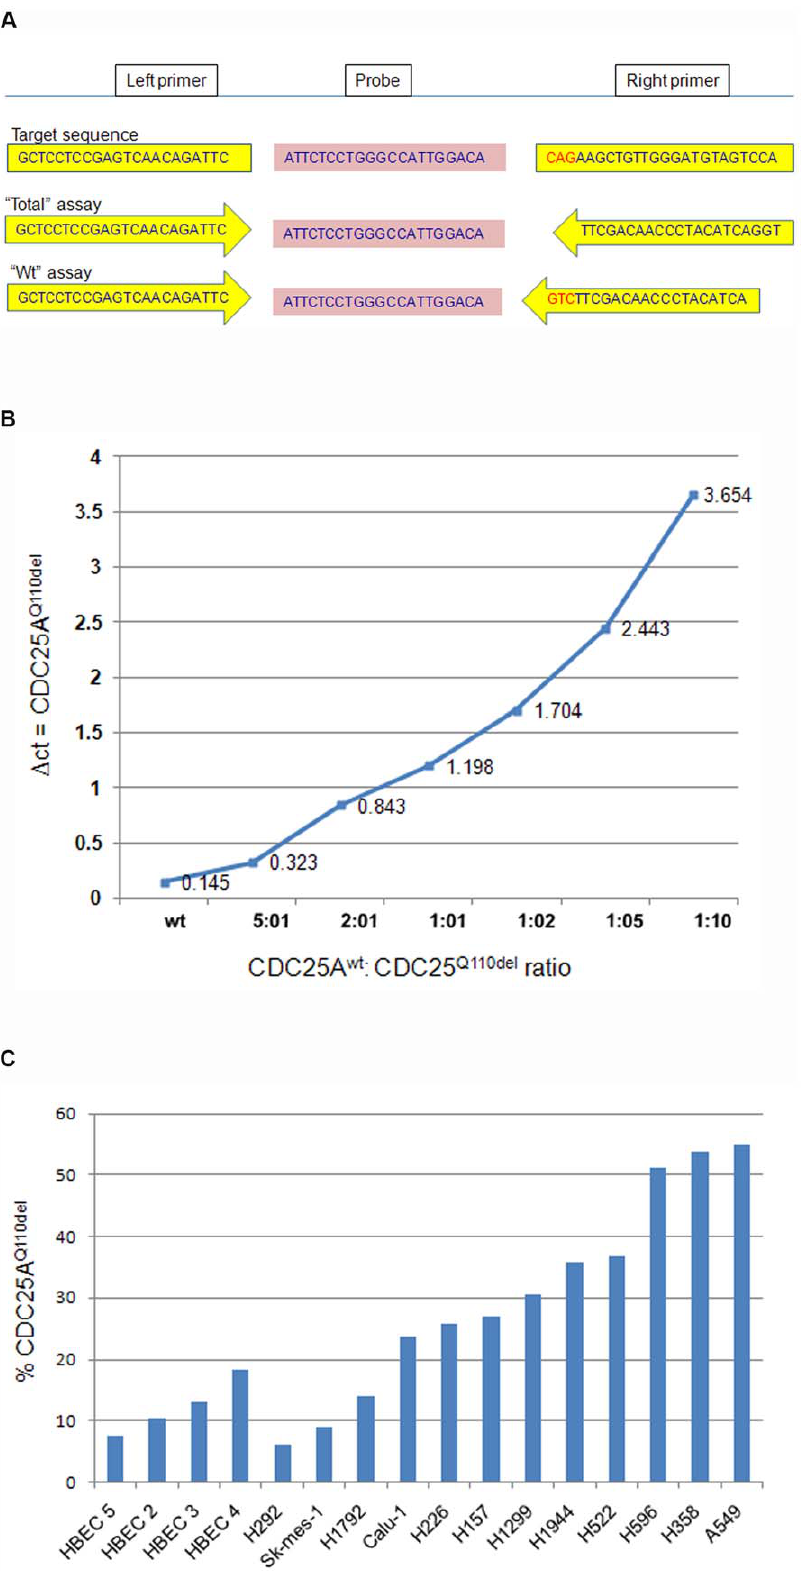
Figure 2. Real time-PCR quantification of CDC25A Q110del in HBEC and NSCLC cell lines. A. Real-time PCR assay to assess the quantity of CDC25A Q110del relative to the total CDC25A transcripts in NSCLC cell lines and tissue samples, the ‘‘Total’’ real time-PCR assay determines total CDC25A template in reaction (Ct tot ) while the ‘‘wt’’ real time-PCR assay determines the target gene which is the CDC25A wt template (Ct wt ), then